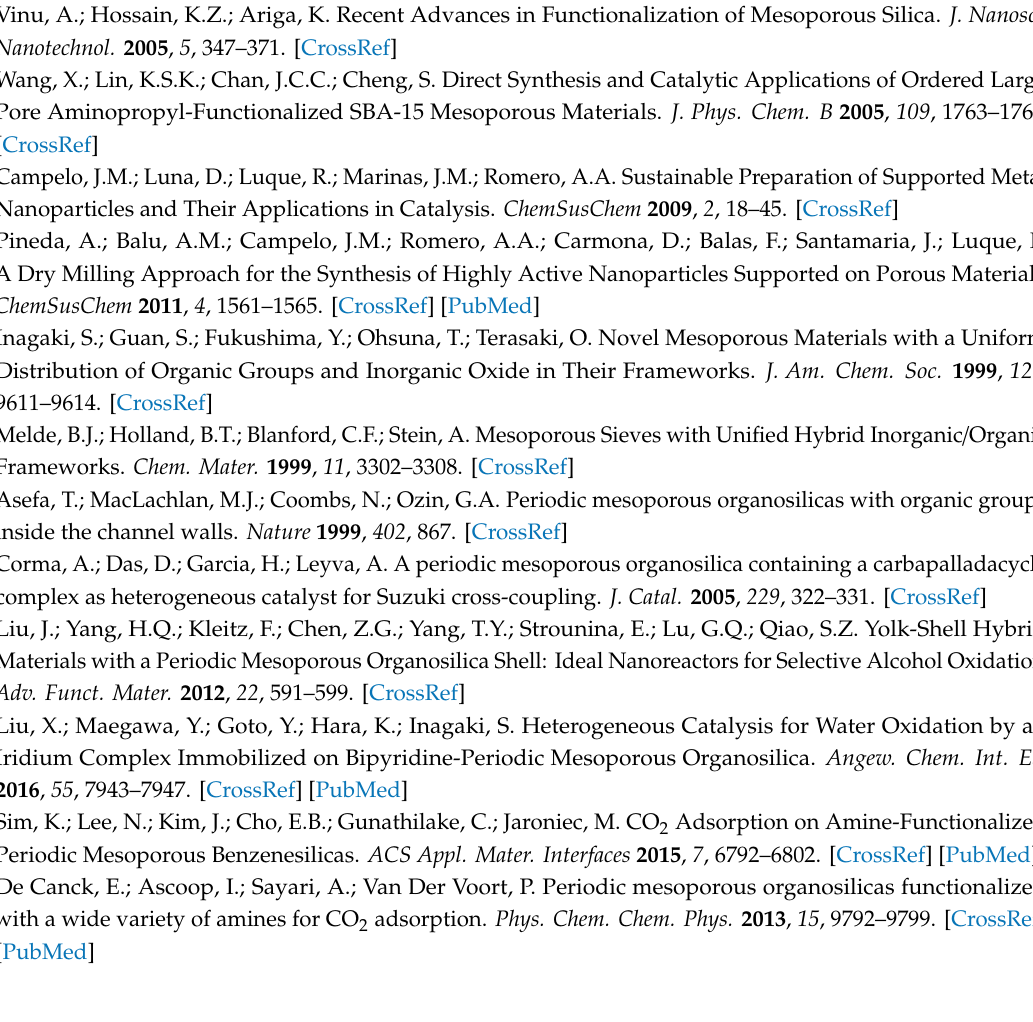
Figure S1: Pore size distribution curve corresponding to the material